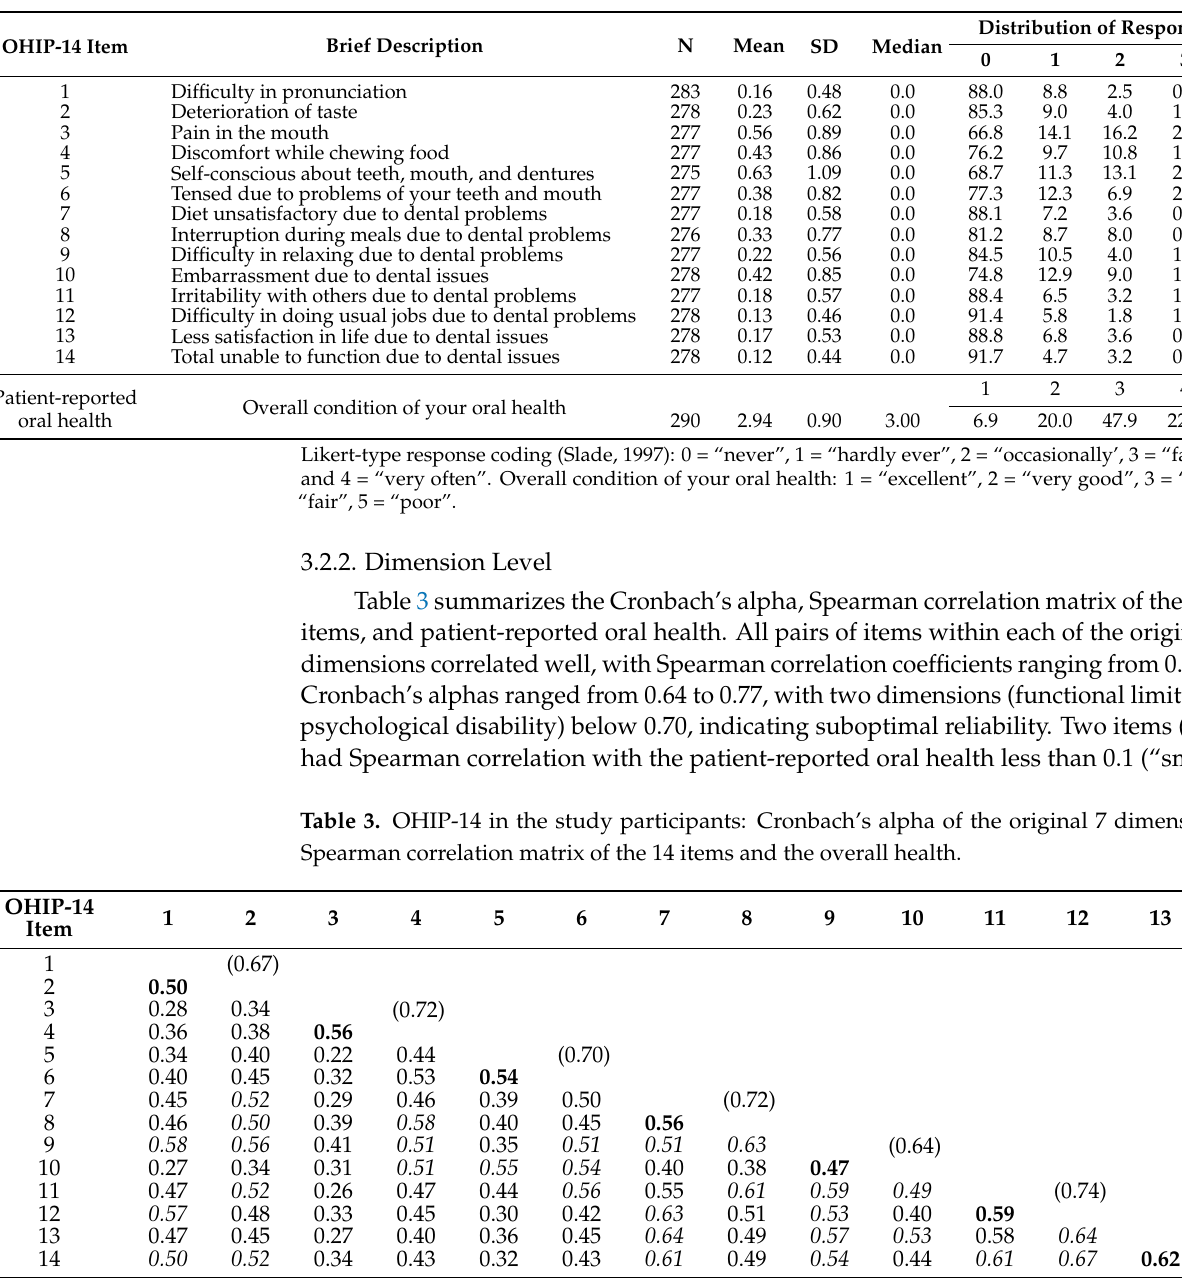
Table 2. Distribution of responses to the OHIP-14 items among the study participants.